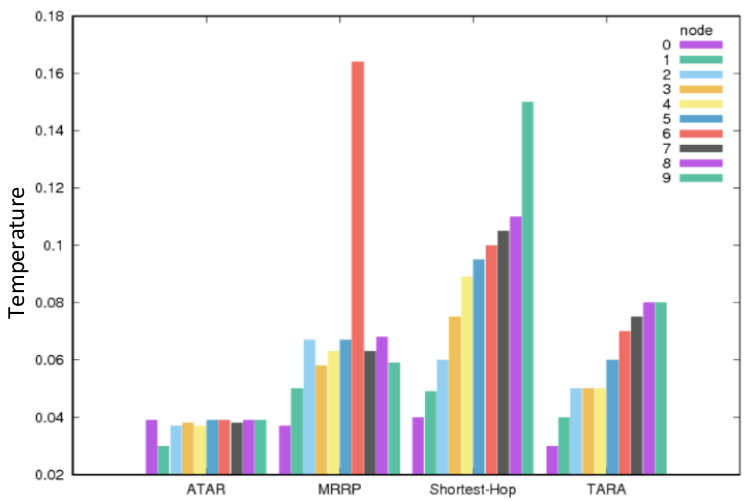
Figure 14. Temperature rise versus simulation time = 3000 s.